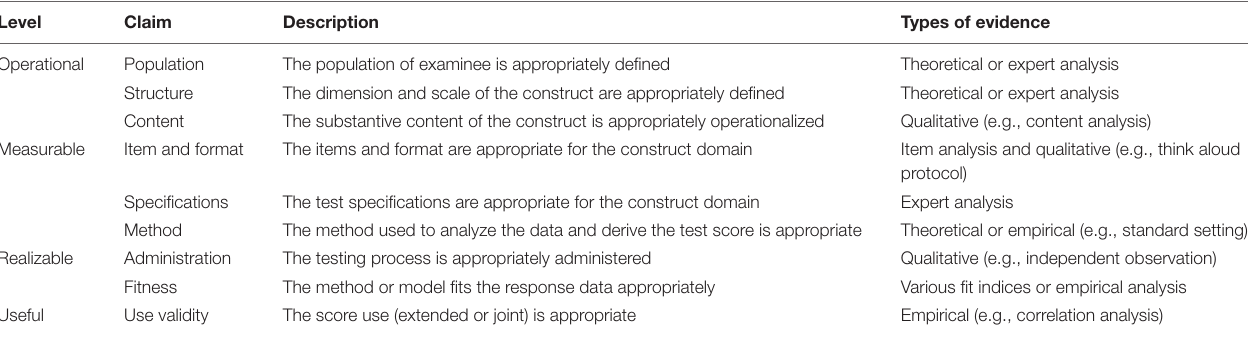
TABLE 1 | Evidence for validity as defined by claims in each hierarchical